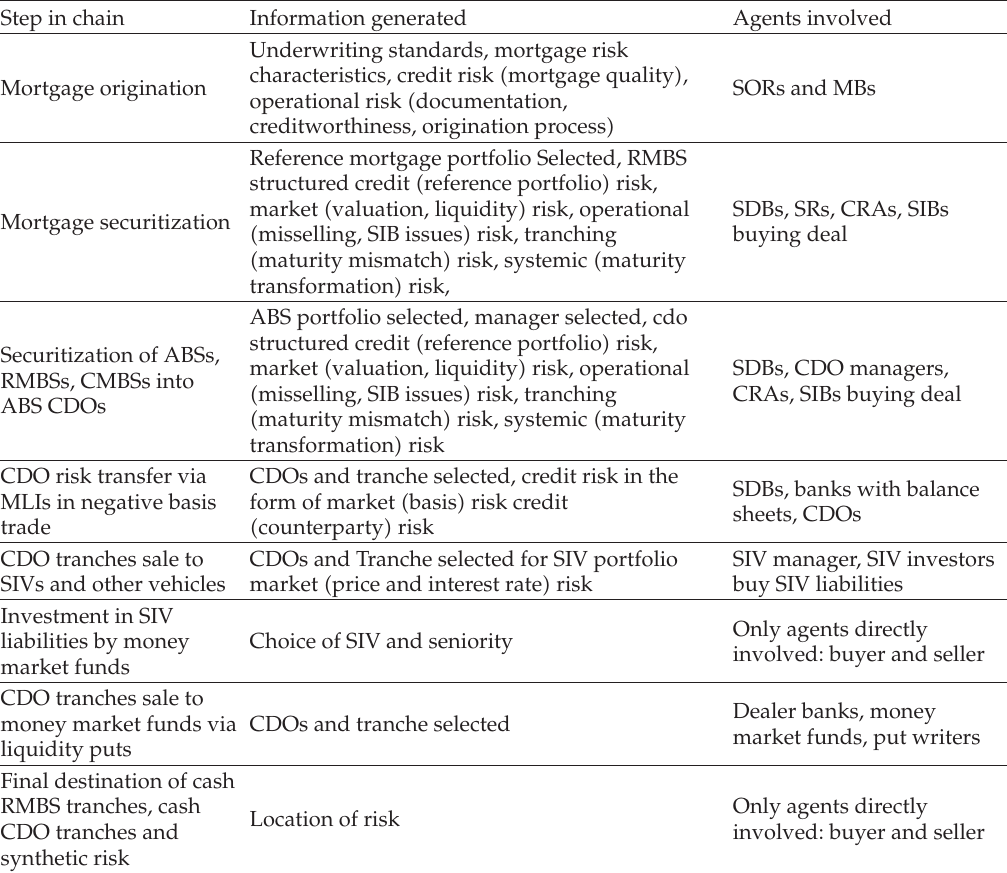
Table 1: Chain of subprime risk and securitization; compare with (cid:6) 6 (cid:7)